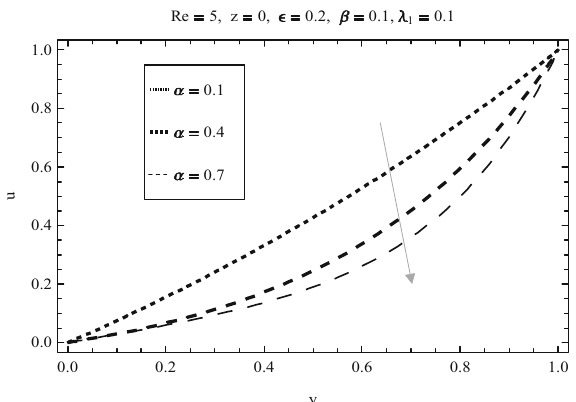
Fig. 2 Velocity component u along y for different values of α